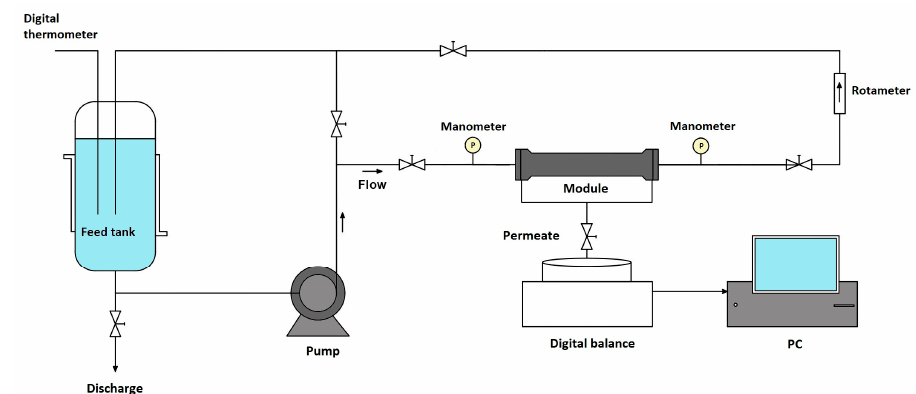
Figure 1. Schematic illustration of the experimental setup for cross-flow